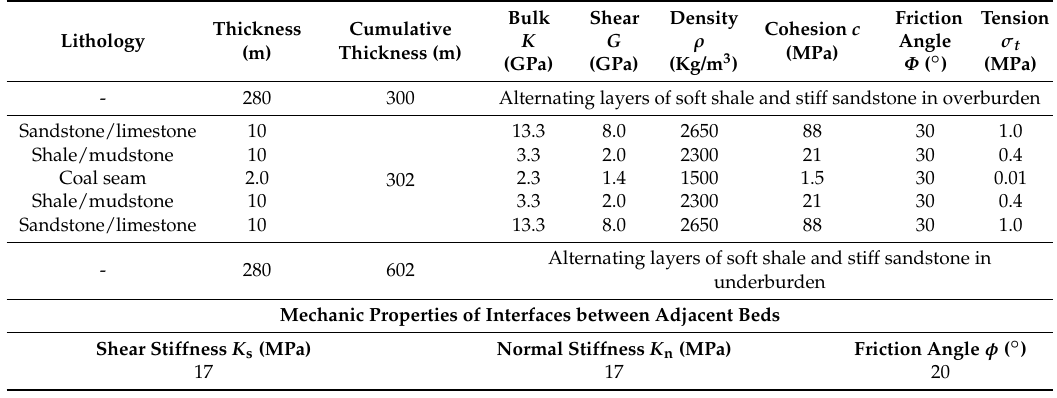
Table 2. Mechanical parameters of rocks and interfaces used in the model (scheme I-2 as an example).